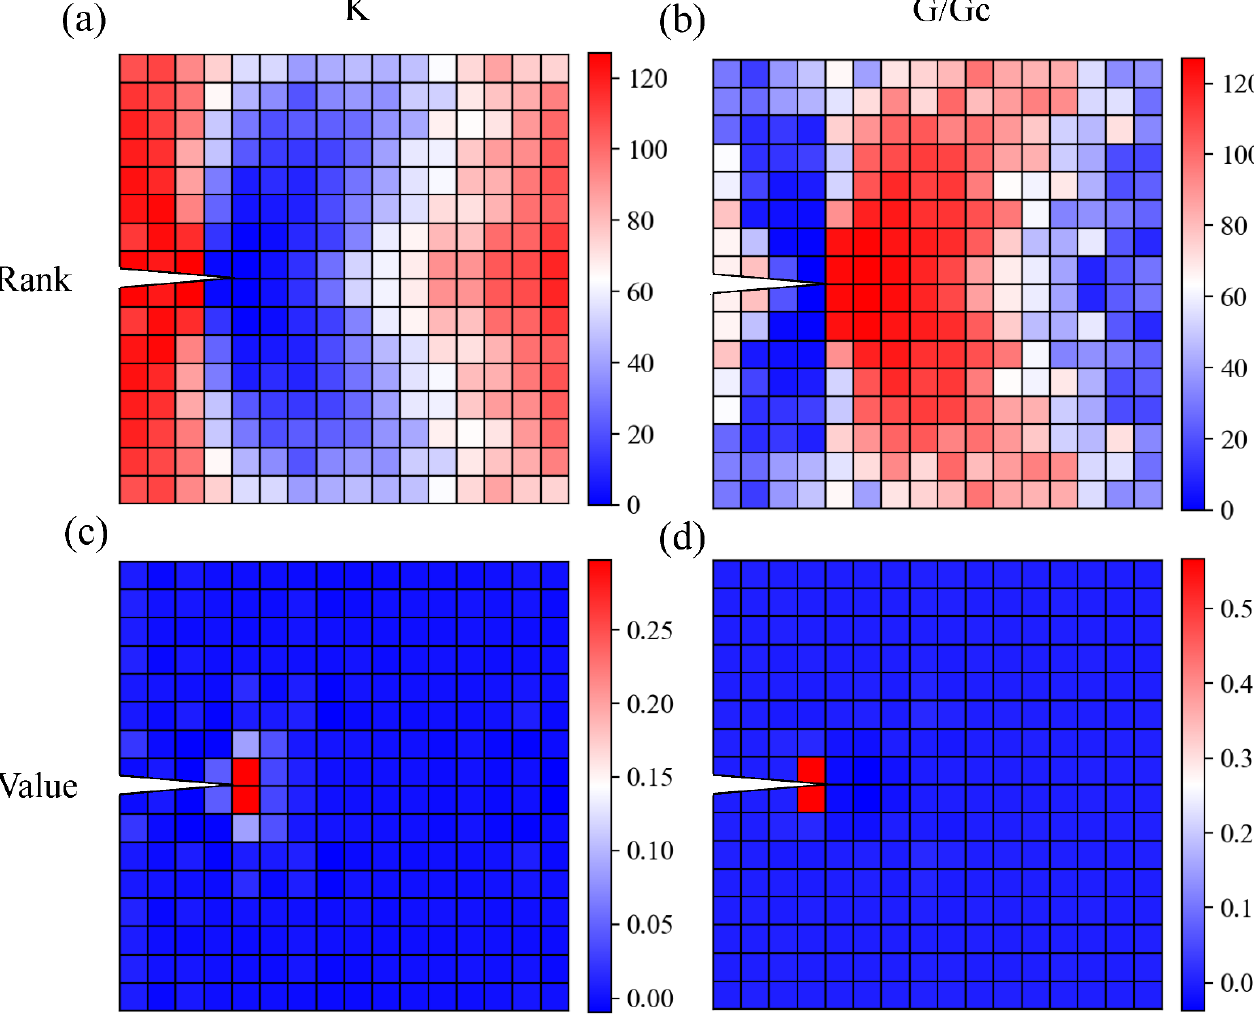
Figure 12. Shapley value plot of each element. ( a ) K by rank. ( b ) G / G c by rank. ( c ) K by value. ( d ) G / G c by value. The unit of K is